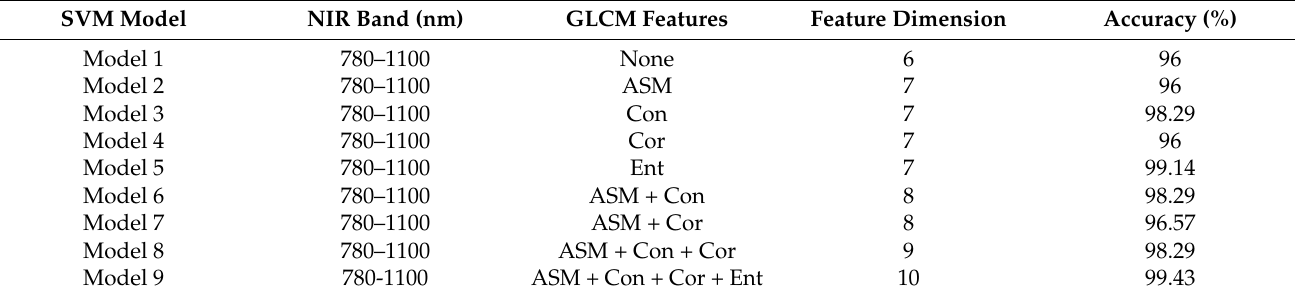
Table 6. Identification accuracy of the SVM model based on the NIR spectra fused with GLCM.